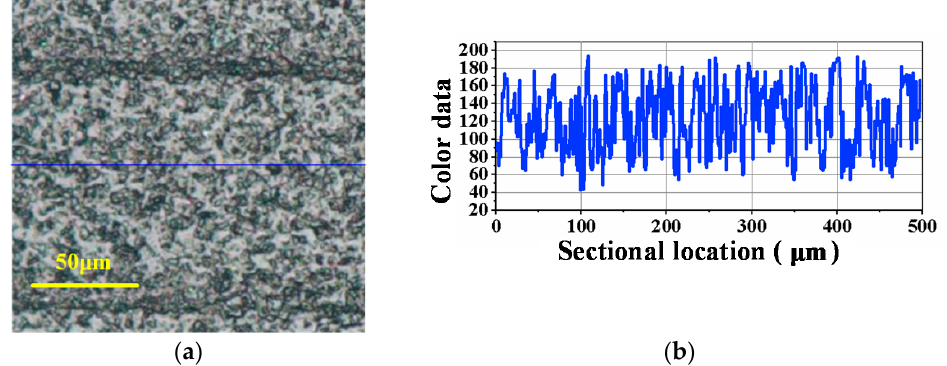
Figure 8. Received SiC surface before single-sided lapping: ( a ) Surface defects; ( b ) Color data of the sectional profile.